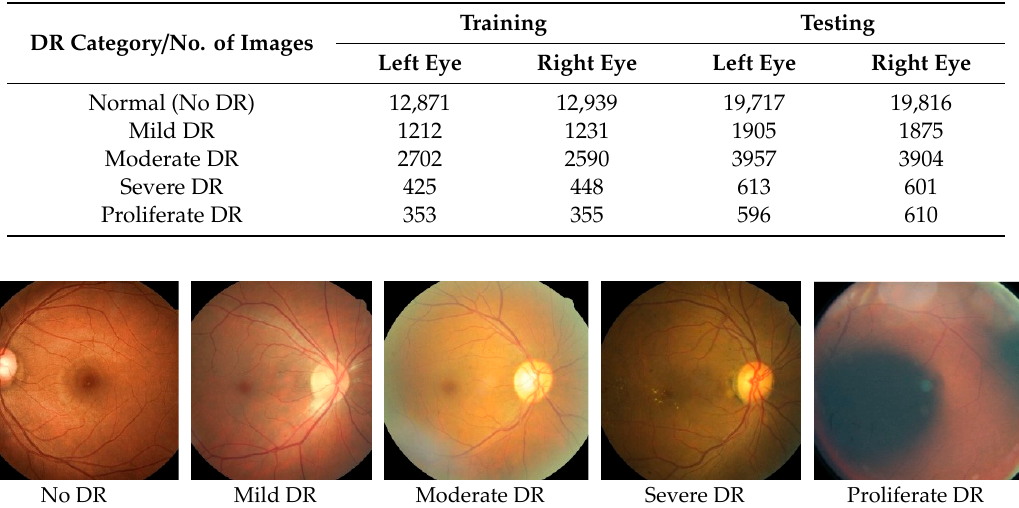
Table 2. The number of images in each diabetic retinopathy (DR) category for training and testing. DR Category / No. of Images